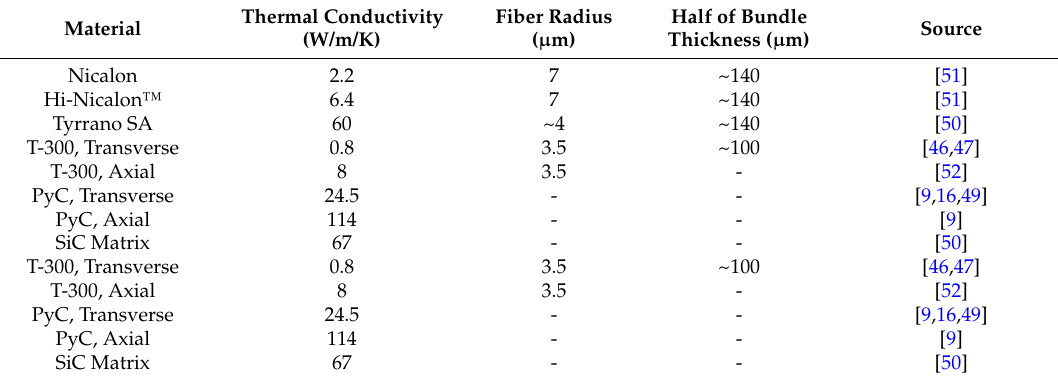
Table 6. Reported data of the components.